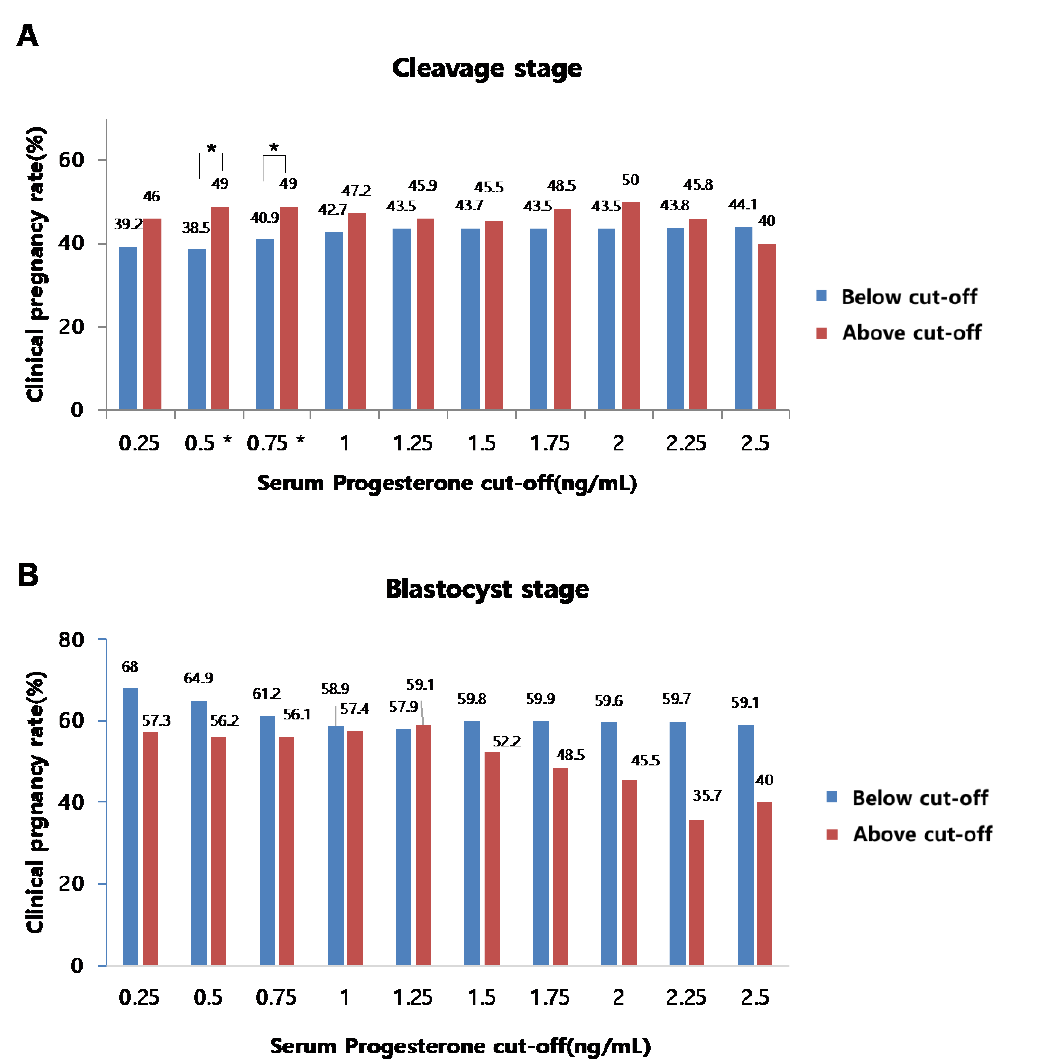
Figure 6. Correlation between serum P4 level on the day of hCG administration and the clinical pregnancy rates at the cleavage stage ( A ) and the blastocyst stage ( B ) ( p < 0.05(*)).